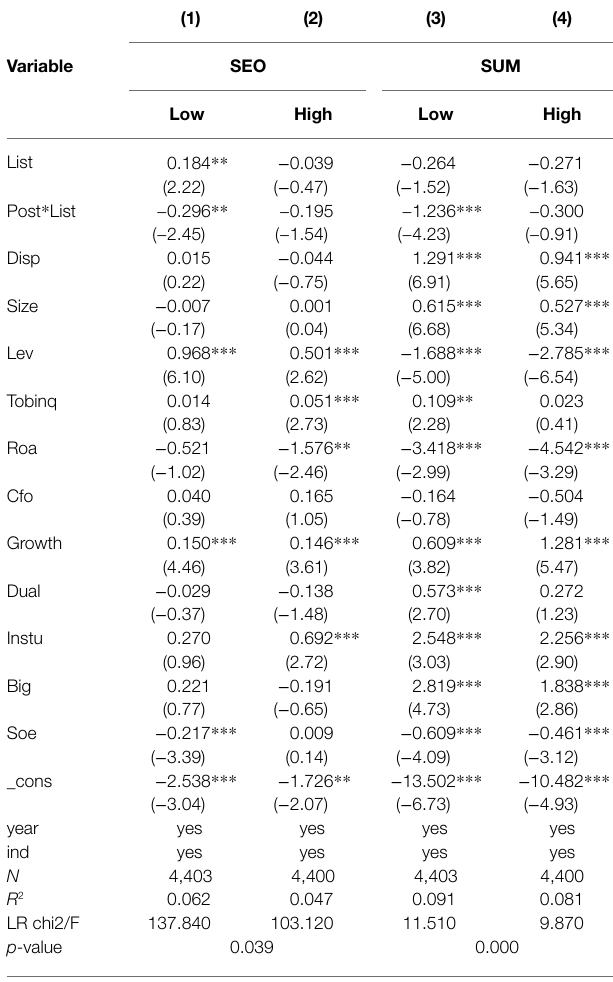
TABLE 8 | Deregulation of short selling and private placement of companies: the level of information transparency.